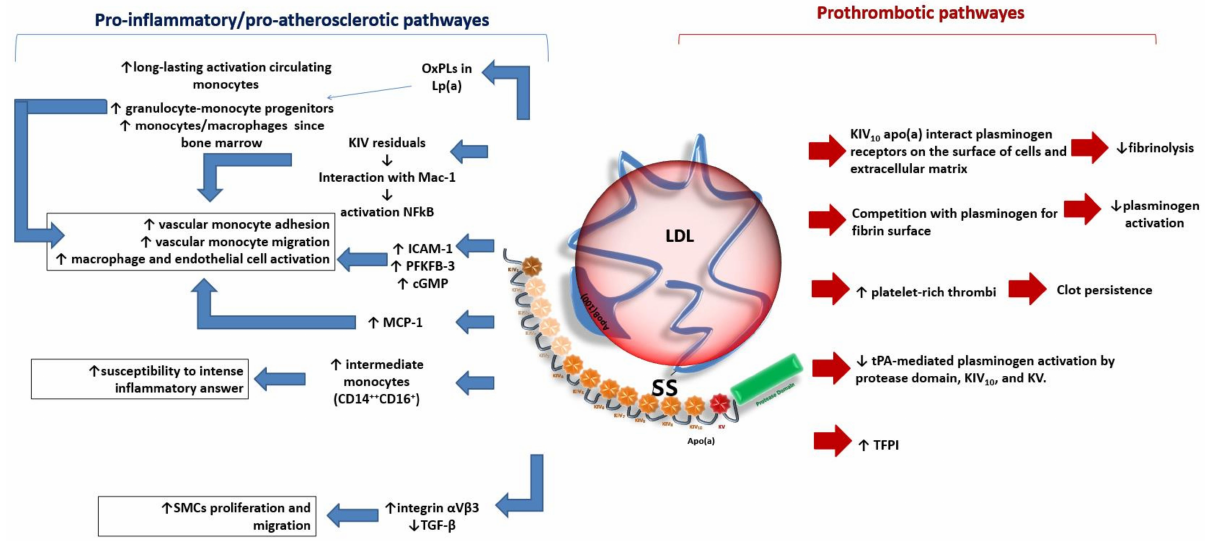
Figure 1. The potential impact of lipoprotein(a) (Lp(a)) on atherosclerotic and thrombotic processes. The figure represents the main hypothetic mechanisms involved in the pathogenesis of atherosclerosis and thrombosis in patients with higher Lp(a) serum concentrations. Apo(a): apolipoprotein(a); CD: cluster of differentiation; cGMP: guanosine 3 (cid:48) ,5 (cid:48) -cyclic monophosphate; ICAM-1: